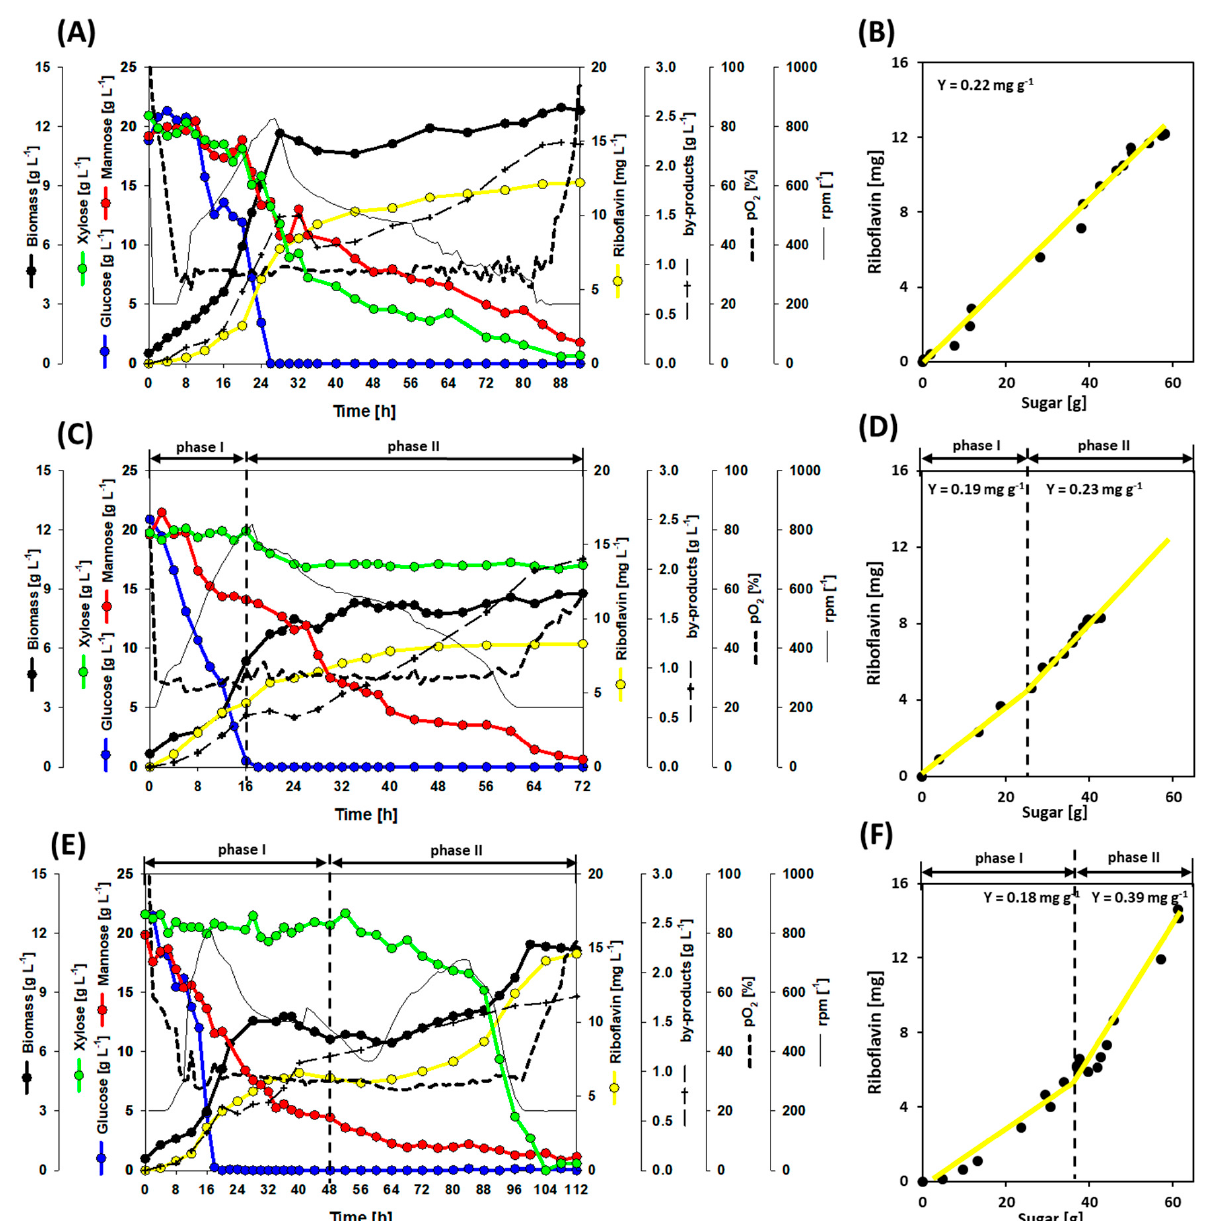
Figure 5. Growth and production of three independent co-cultivation batch fermentations with the strains RiboMan and RiboXyl. ( A ) RiboMan and RiboXyl were inoculated together at the beginning of the process; ( B ) yields for riboflavin achieved when inoculating RiboMan and RiboXyl together; ( C ) RiboXyl was inoculated during the exponential phase of RiboMan; ( D ) yields for riboflavin achieved when inoculating RiboXyl during the exponential phase of RiboMan where phase I indicates before inoculation of RiboXyl and phase II indicates after inoculation of RiboXyl; ( E ) RiboXyl was inoculated during the stationary phase of RiboMan; ( F ) yields for riboflavin achieved when inoculating RiboXyl during the stationary phase of RiboMan where phase I indicates before inoculation of RiboXyl and phase II indicates after inoculation of RiboXyl. Data is depicted as follows: glucose consumption (blue line), mannose consumption (red line), xylose consumption (green line), riboflavin accumulation (yellow line), biomass formation (thick black line), stirring profile (thin black line), pO2 profile (dotted line), and the sum of by-products (dashed line) (by-products details in Figure 6). One replication of each cultivation was carried out.